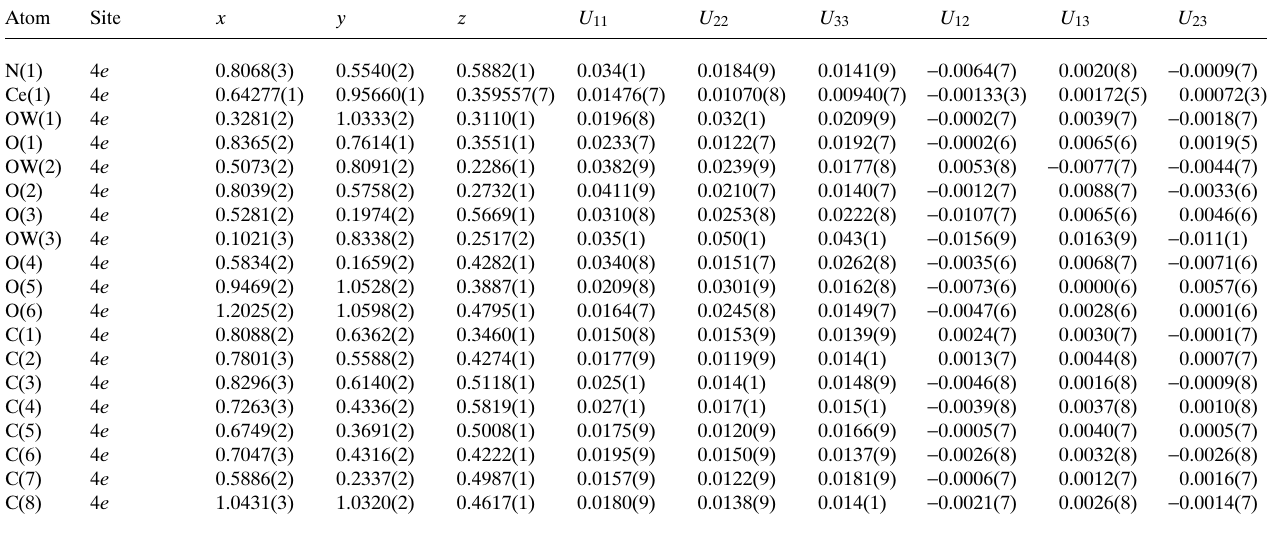
Table 3. Atomic coordinates and displacement parameters (in Å 2 ) .